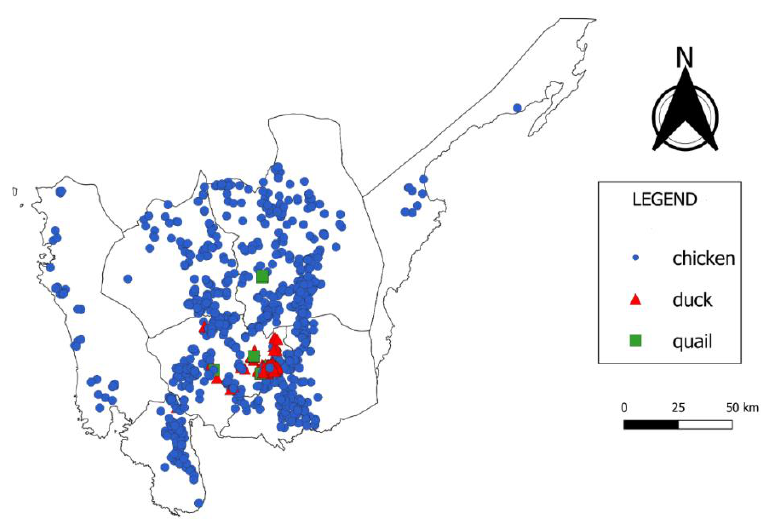
Figure 2. Map of Central Luzon, Philippines showing the physical location of all 1151 commercial poultry farms. Chicken farms are represented by blue dots. Quail farms are represented by green squares. Duck farms are represented by red triangles.